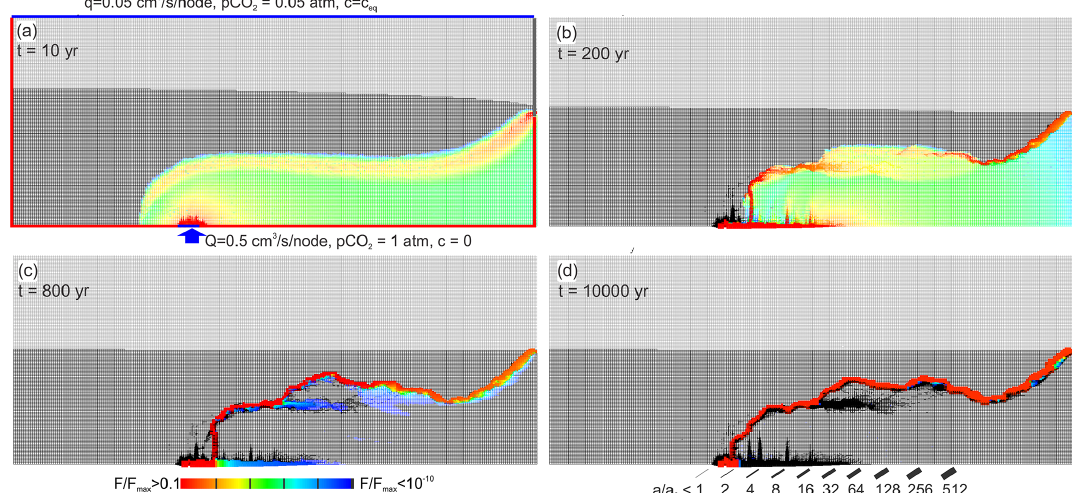
Figure 12. Standard scenario but upwelling water is undersaturated with respect to calcite, c in = 0. The red region indicates high rates of fracture widening. The highly aggressive water is channeled to the mixing zone at the water divide.